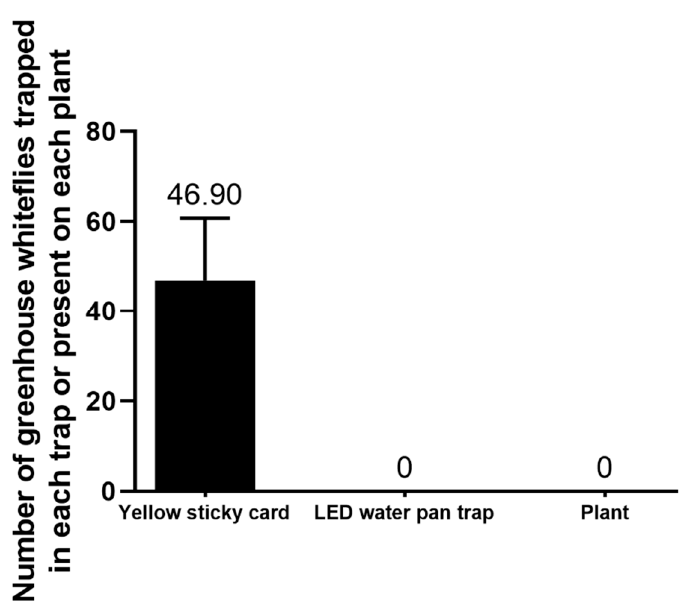
Figure 2. Efficacy comparison of the LED water pan trap, yellow sticky card and personal plant checking on the population monitoring of T. vaporariorum from 14 May to 17 June 2019. The error bar represents the standard error.